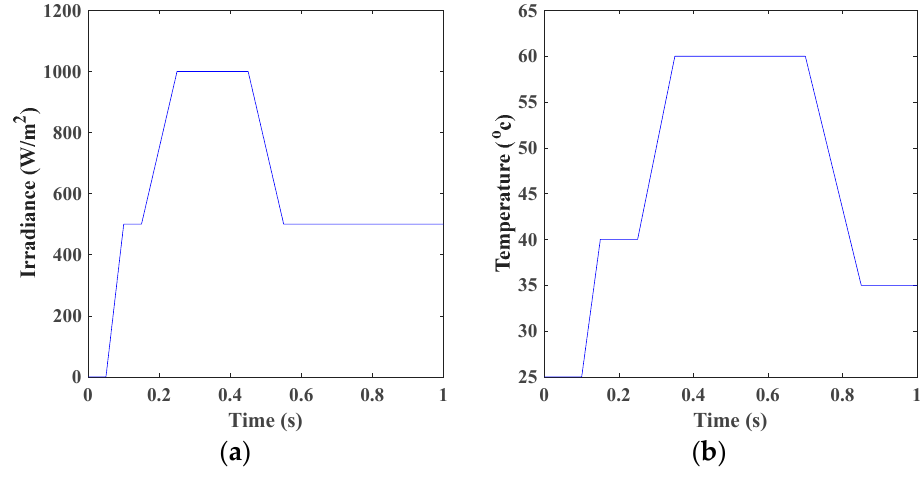
Figure 12. Simultaneous ramp changes in both ( a ) solar irradiance and ( b ) temperature.